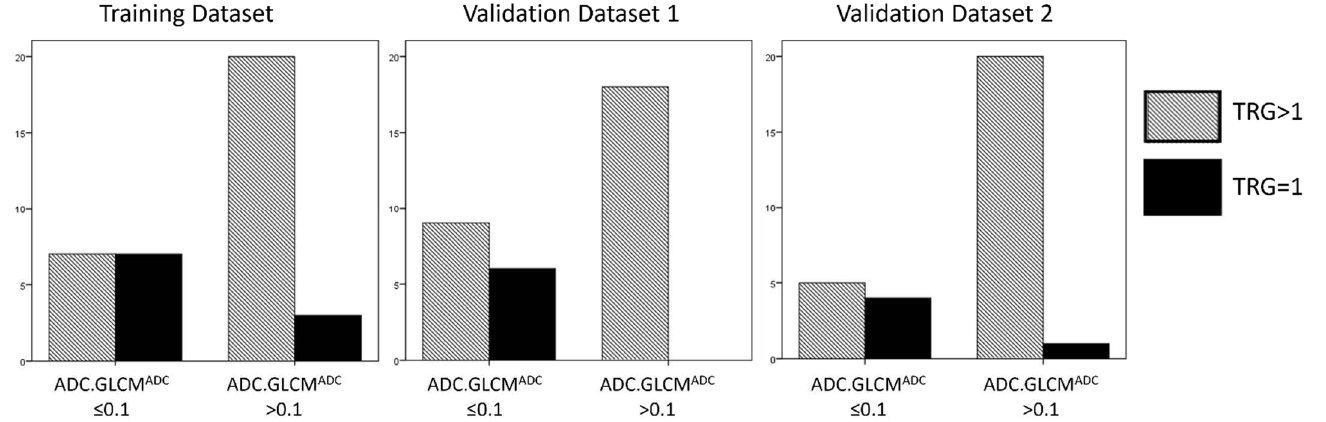
Figure 3. The cut-off of ADC GLCM Entropy calculated on the training dataset was equal to − 0.10. Using this cut-off, the sensibility of the model in the training and in the two validation datasets, respectively, was 70%, 73%, and 100%, the specificity of the models was 74%, 66.7%, and 80%, and the accuracy of the model was 73%, 72.7%, and 80%. Figure 2. ROC Curve for the prediction of pCR (TRG 1) for training dataset ( left ) and validation datasets ( right ).